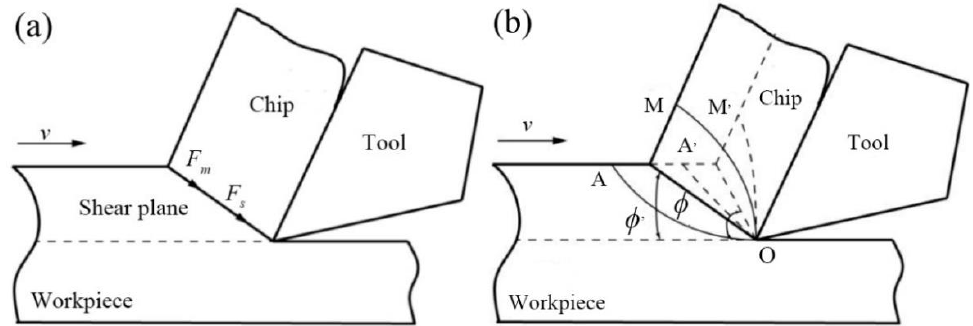
Figure 10. Effect of cutting speed on the shear deformation of workpieces: ( a ) shear plane stress; ( b ) shear angle variation.